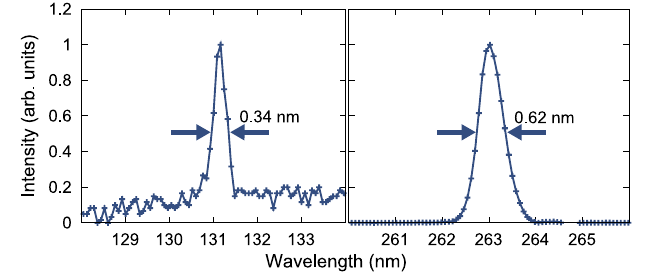
compression.FIG. 7. Full-width half maximum linewidth of a peak mea- sured at 131 and 263 nm is used to estimate the pulse length. Both spectra are normalized. The noise is less prominent on the fundamental due to higher